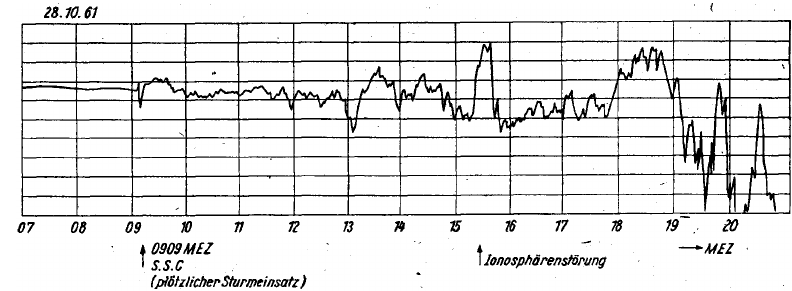
Figure 20. Field balance system, developed by Gerhard Fanselau.